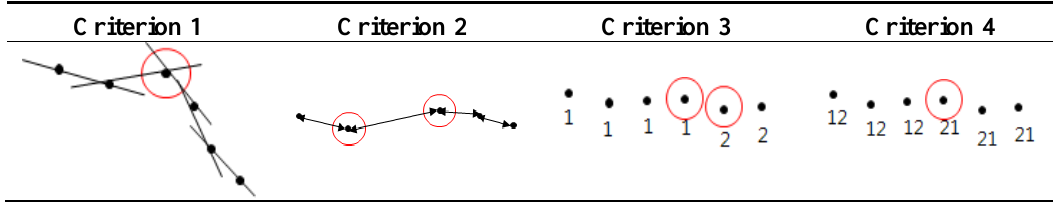
Table 4. Visual examples of criteria for extracting significant